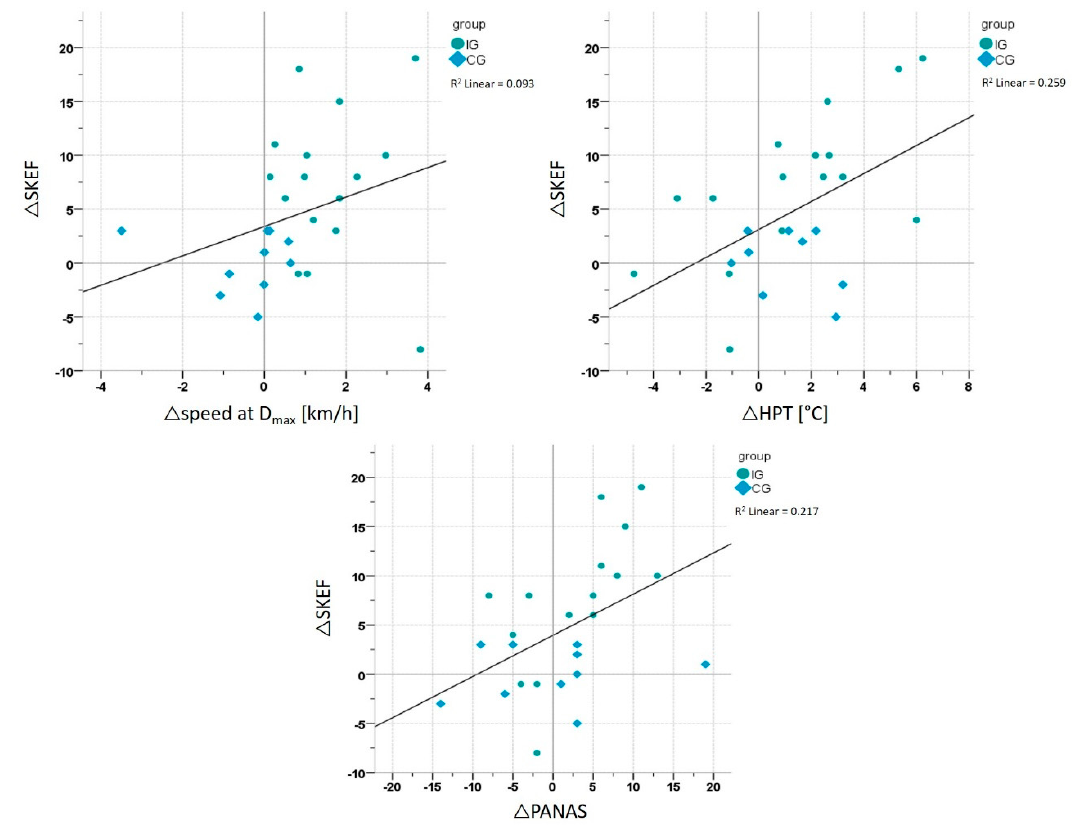
Figure 7. Correlation analysis whole sample. Correlation between the SKEF (‘physical efficacy’) and speed at D max , the PANAS Positive Affect Scale and HPT (heat pain threshold) for both groups (IG = intervention group and CG = control group) together.